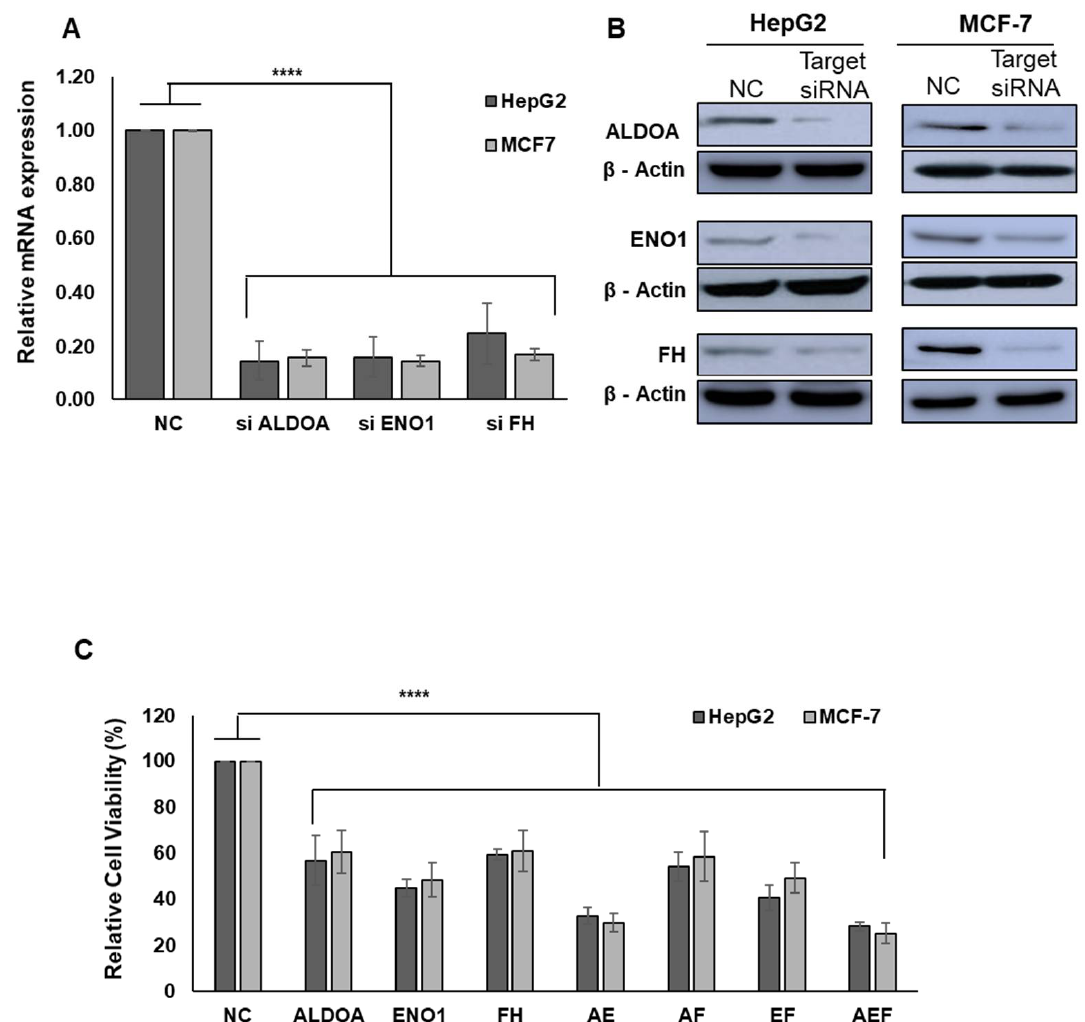
Figure 4. ( A ) The effect of siRNA-mediated gene knockdown on the expression level of ALDOA , ENO1 , and FH mRNA. ( B ) The effect of ALDOA -, ENO1 -, and FH -targeted siRNAs in HepG2 and MCF-7 cells. Lysates were prepared from cells pretreated with 1.2 nM of siRNA against a single-target enzyme. β -actin was used as a loading control. Total cellular proteins were separated using SDS-PAGE, transferred to PVDF membranes, and detected using specific antibodies against ALDOA , ENO1 , FH , and β -actin. ( C ) The viability of HepG2 and MCF-7 cells (expressed as a percentage of the control) was determined using a CellTiter Glo luminescent assay kit. The cells were treated for 72 h with 1.2 nM of single-target siRNA ( ALDOA , ENO1 , or FH ) and 1.2 nM of siRNA against more than one target (a combination of ALDOA , ENO1 , and FH ). Data were obtained from three independent experiments and presented as mean ± SD., **** p < 0.0001 versus the negative control siRNA (NC) group.